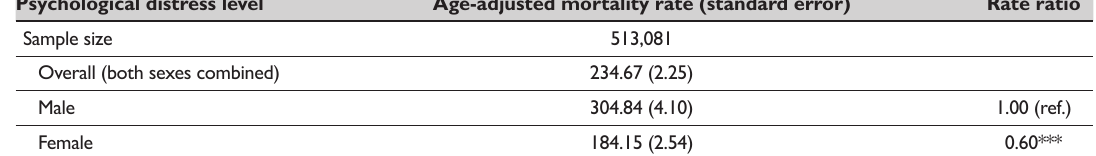
Table 2: Age-adjusted heart disease mortality rates per 100,000 person-years by psychological distress level (K6) in the United States, 1997-2014 Psychological distress